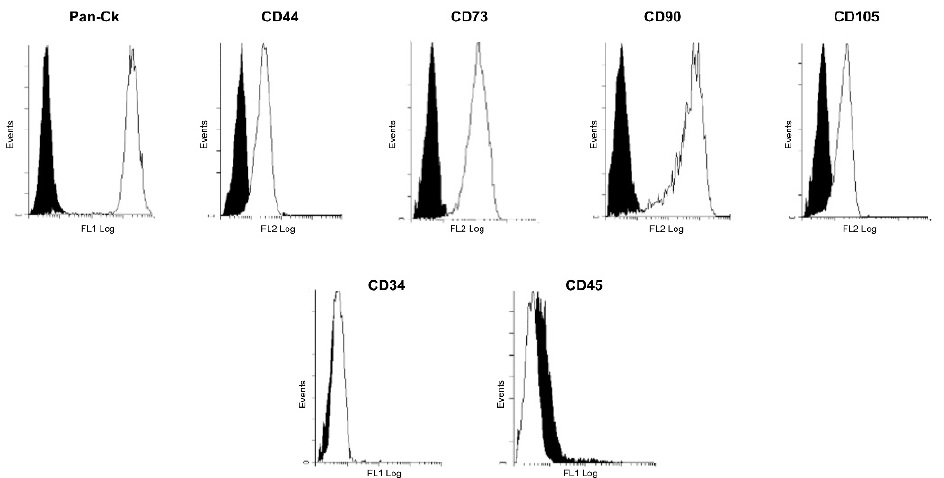
Figure 1. Immunophenotype of isolated human Amniotic Epithelial Cells (hAECs). Flow cytometry analysis of epithelial (Pan-Cytokeratin, Pan-Ck), mesenchymal (CD44, CD73, CD90, CD105), and hematopoietic (CD34, CD45) markers. Data are representative of three independent experiments obtained from three human samples. Black and white histograms represent the unstained controls and the specific cell markers, respectively.